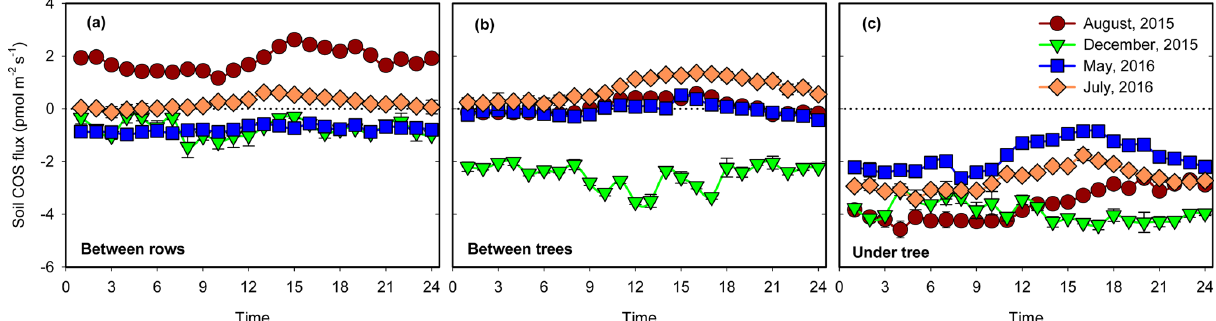
Figure 1. Spatial variability of soil COS flux at three sites: between trees (a) , between rows (b) and under tree (c) . Each panel shows the diurnal cycling of soil COS flux in the four campaigns. Each data point was the hourly mean ± 1 SE ( N = 3).